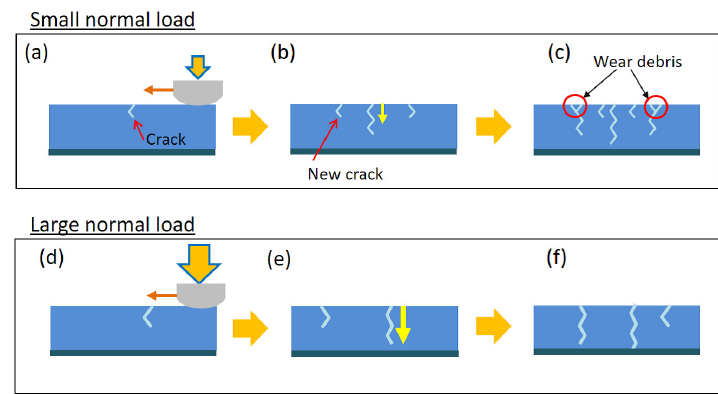
Figure 7. Schematic of propagation mechanisms of fatigue cracks and formation mechanisms of wear debris ( a – c ) for small normal loads and ( d – f ) for large normal loads. We note that the crack speed, i.e., time to rupture, was different between these two